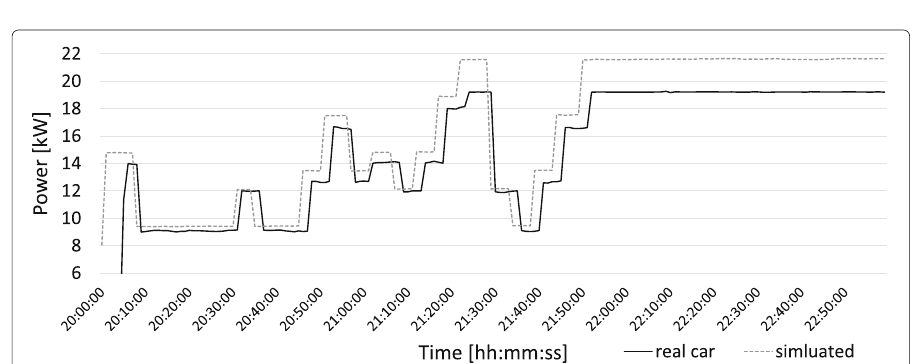
Fig. 12 Comparison of a the simulated charging signal with the reaction of a real car. The tested real car follows nearly the simulated power, except from the starting phase which takes some time. Contrarily to the Fig. 11, the SoC of the tested car is low, hence, the saturation phase does not show in this